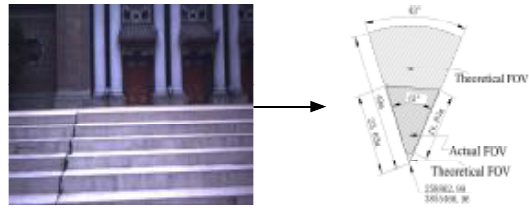
Figure 6. Comparison of the actual and theoretical FOV in 2D